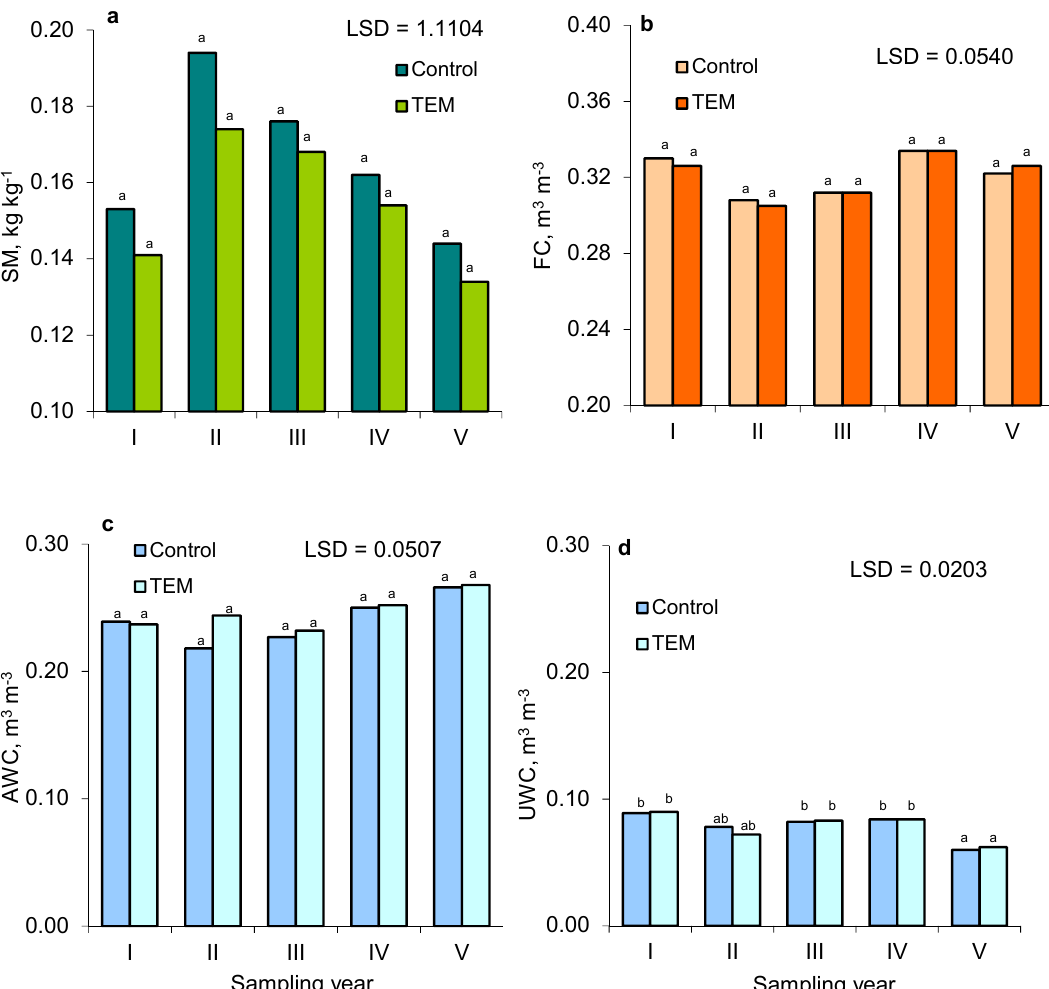
Figure 6. The annual mean values of soil water properties: soil moisture (SM) ( a ), field water capacity (at − 15.5 kPa) (FC) ( b ), available water content (AWC) ( c ), and unavailable water content (UWC) ( d ) during the five-year study. Notes: Control: soil without EM-A ( n = 150), TEM: soil with EM-A application ( n = 150), I–V: study year. Each letter (a, ab and b) means a significant di ff erence